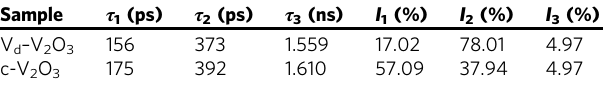
Table 1 Position lifetime parameters of V d – V 2 O 3 and c-V 2 O 3